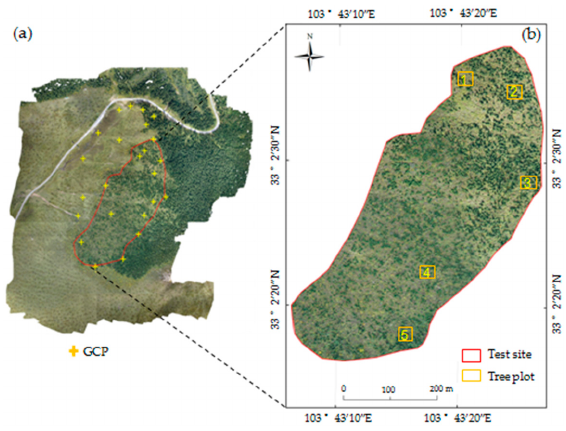
Figure 3. Resulting Digital Orthophoto Map (DOM) of the test site and the spatial distribution of sample tree